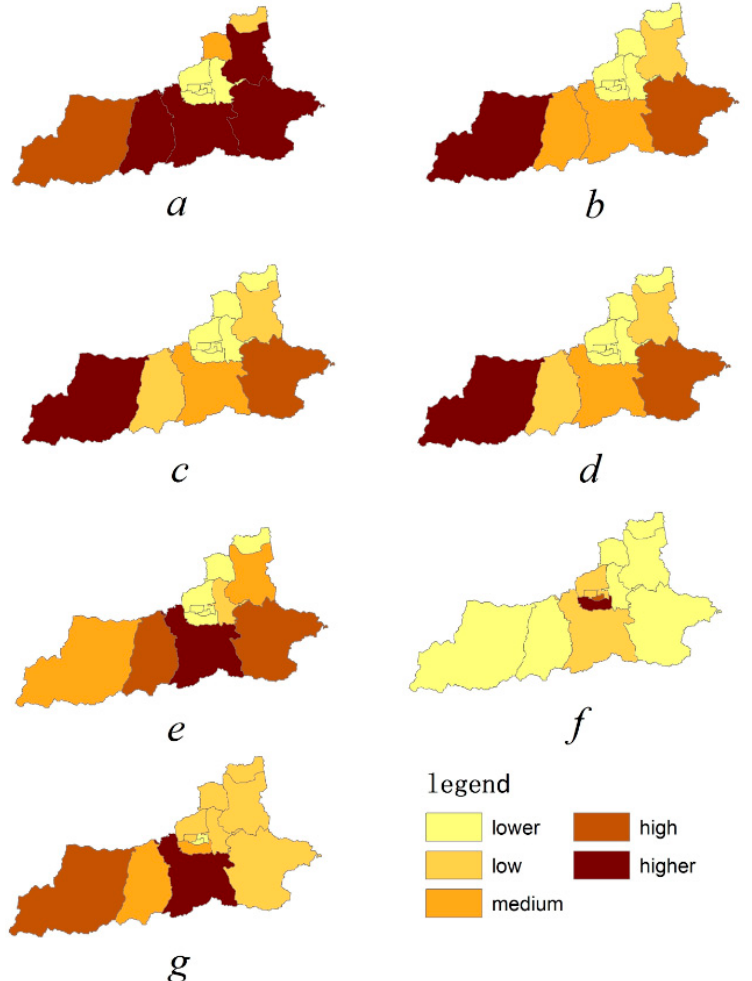
Figure 6. Ecosystem service supply across the 13 districts: ( a ) Food and fiber; ( b ) Freshwater; ( c ) Carbon sequestration; ( d ) Moderation of extreme events; ( e ) Spiritual and sense of place; ( f ) Recreational and mental health; ( g ) Esthetic appreciation and cultural inspiration.